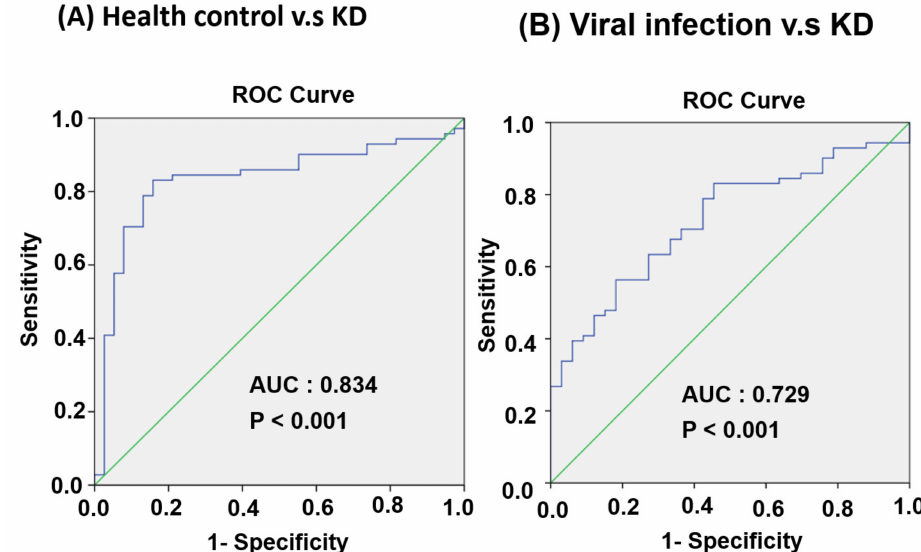
Figure 7. Evaluation of plasma miR-24-3p for the diagnosis of patients with KD. ROC curves comparing plasma miR-24-3p expression levels between the KD and control groups. ( A ) Healthy control and KD groups. ( B ) Viral infection and KD